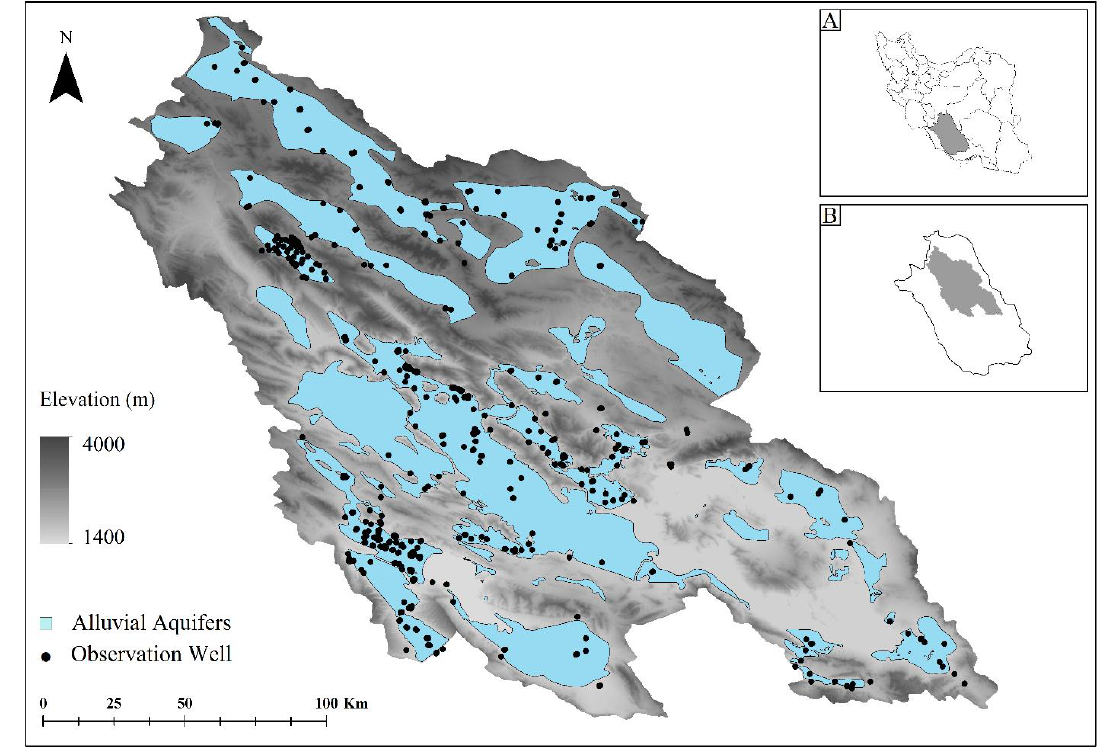
Figure 1. Distribution of alluvial aquifers and observation wells in Bakhtegan catchment. Inserts: Location of ( A ) Fars province in Iran and ( B ) the Bakhtegan catchment in Fars province. The stacked bar graph shows the elevation from sea level variation in the catchment.